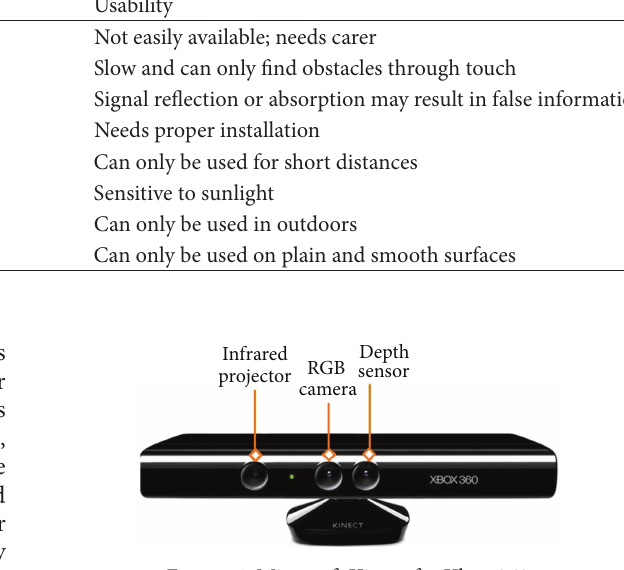
Figure 1: Microsoft Kinect for Xbox